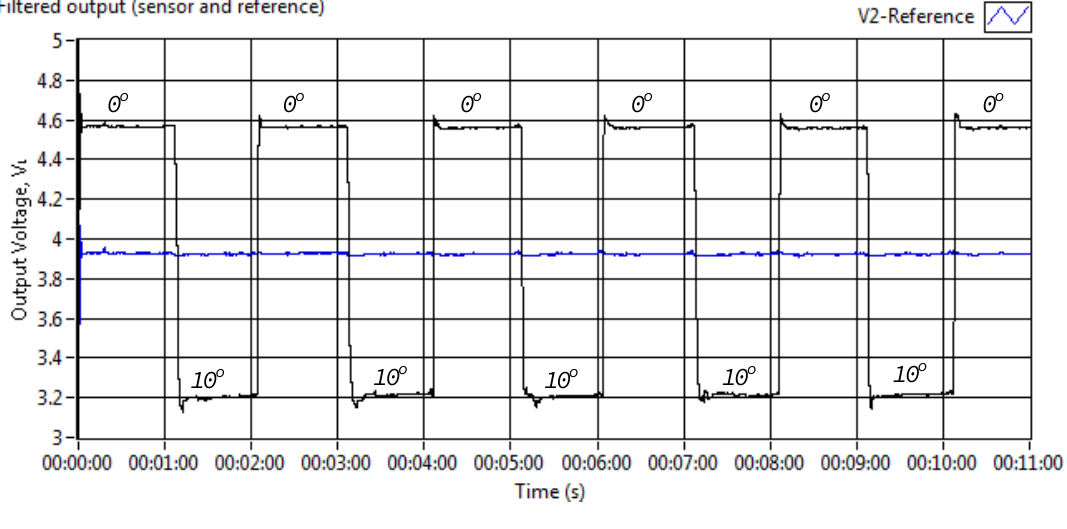
Figure 7. Voltage drift test—output voltage